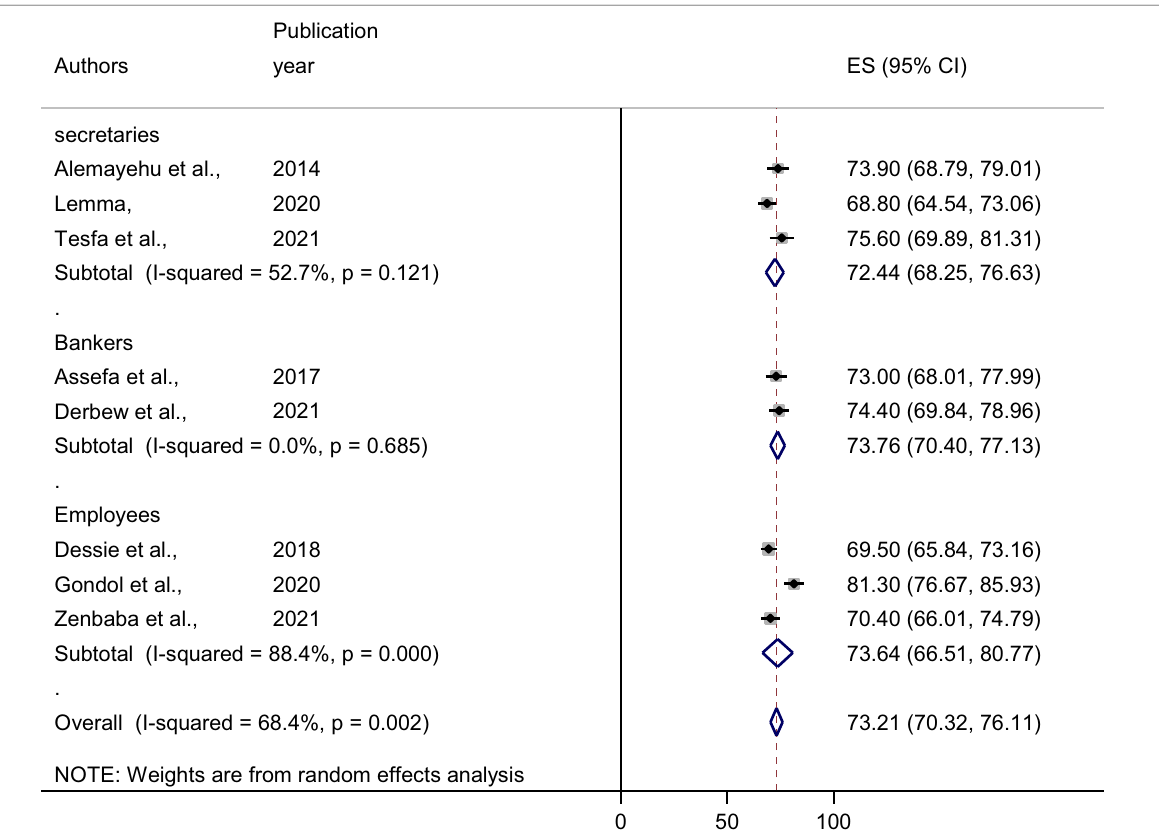
Fig. 3 Forest plot of the Subgroup analysis of the prevalence of computer vision syndrome in different professions in Ethiopia, 2021